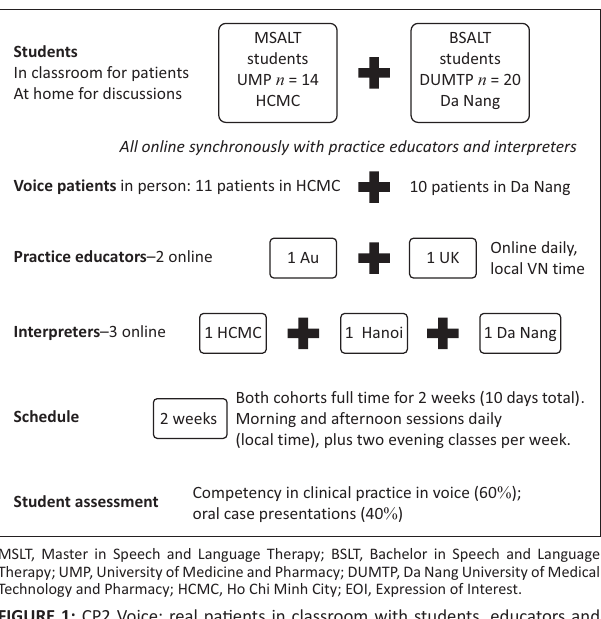
FIGURE 1: CP2 Voice: real patients in classroom with students, educators and interpreters online.